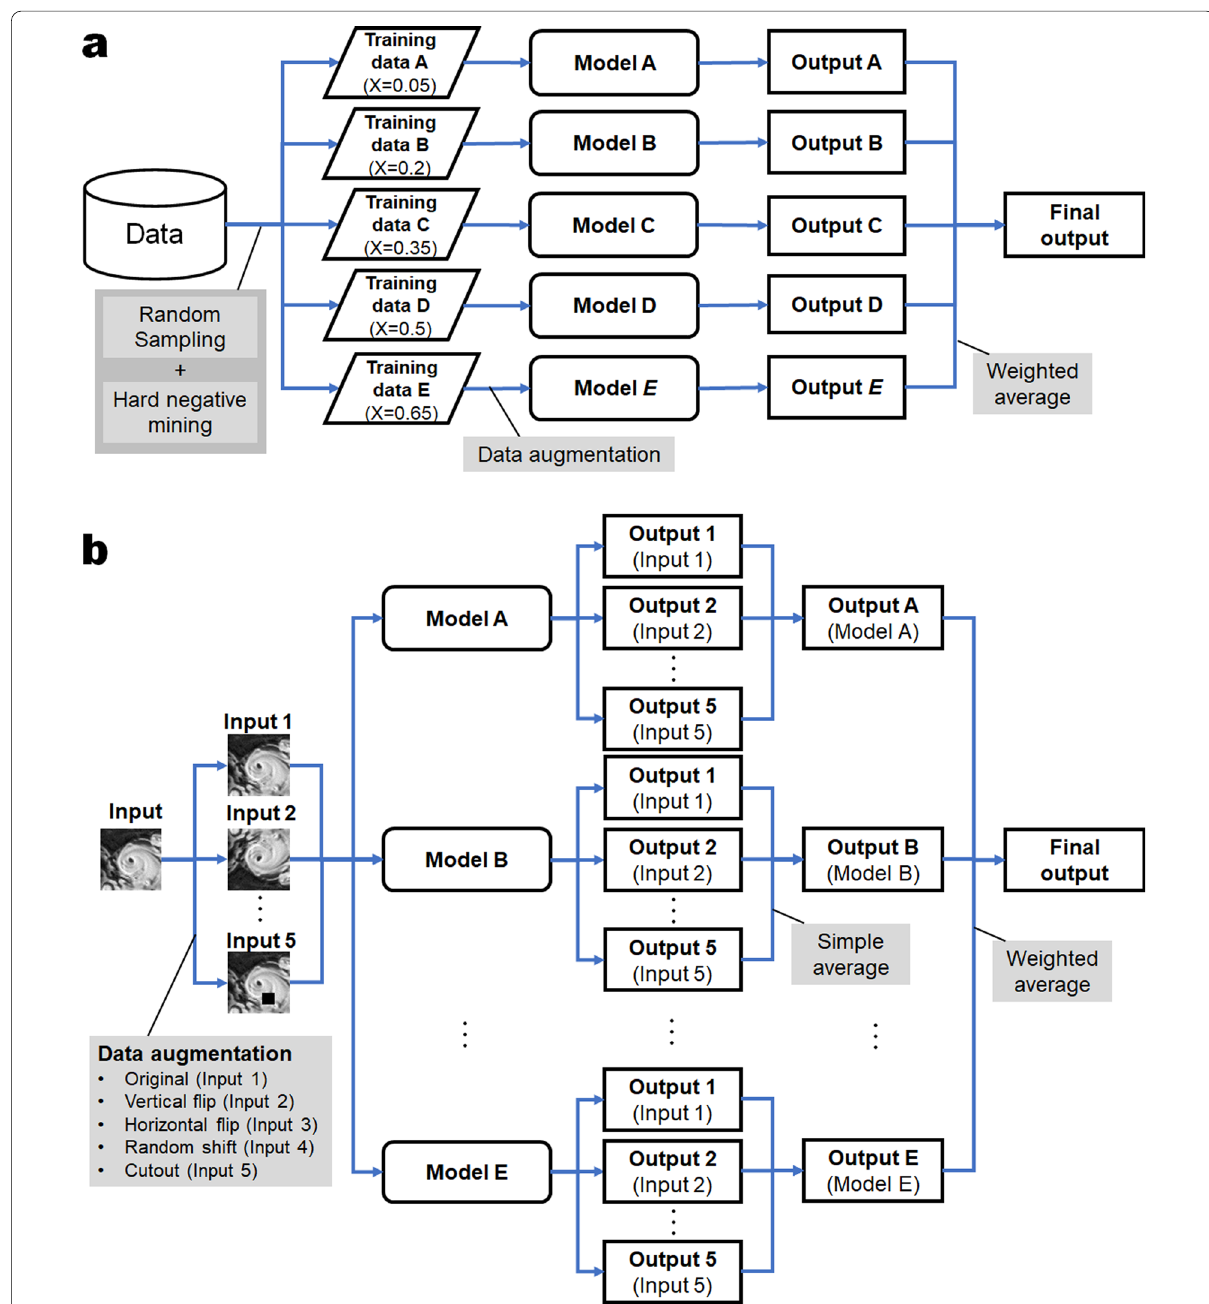
Fig. 5 Proposed ensemble learning model. a Training and b test